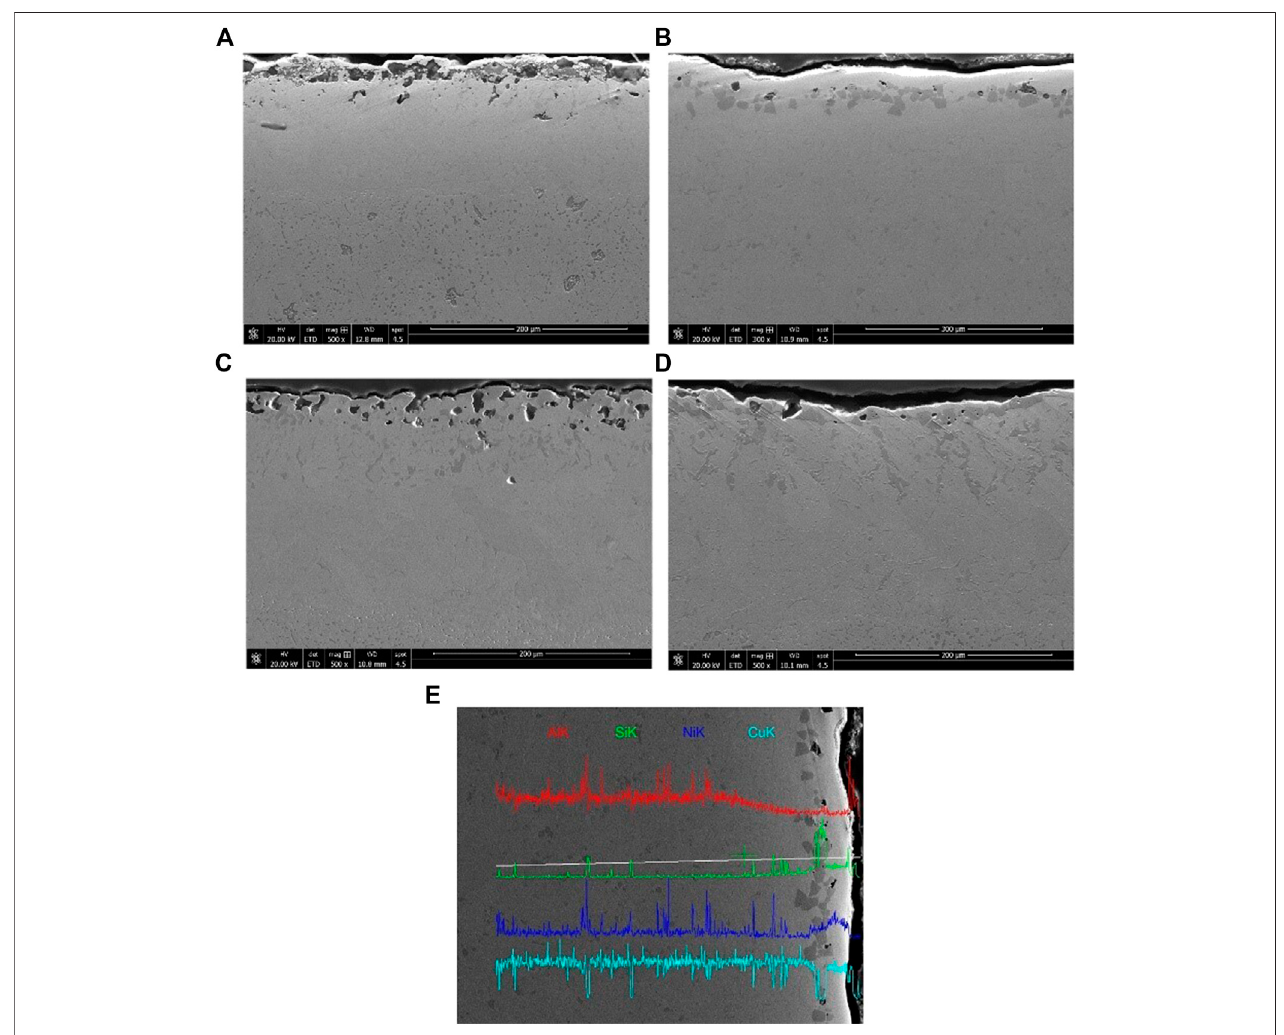
FIGURE 3 | Surfaces of the siliconized layer under the condition of different Si powder ratio. (A) 10%; (B) 30%; (C) 50%; (D) 70%; (E) EDS mapping of 30% Si content.